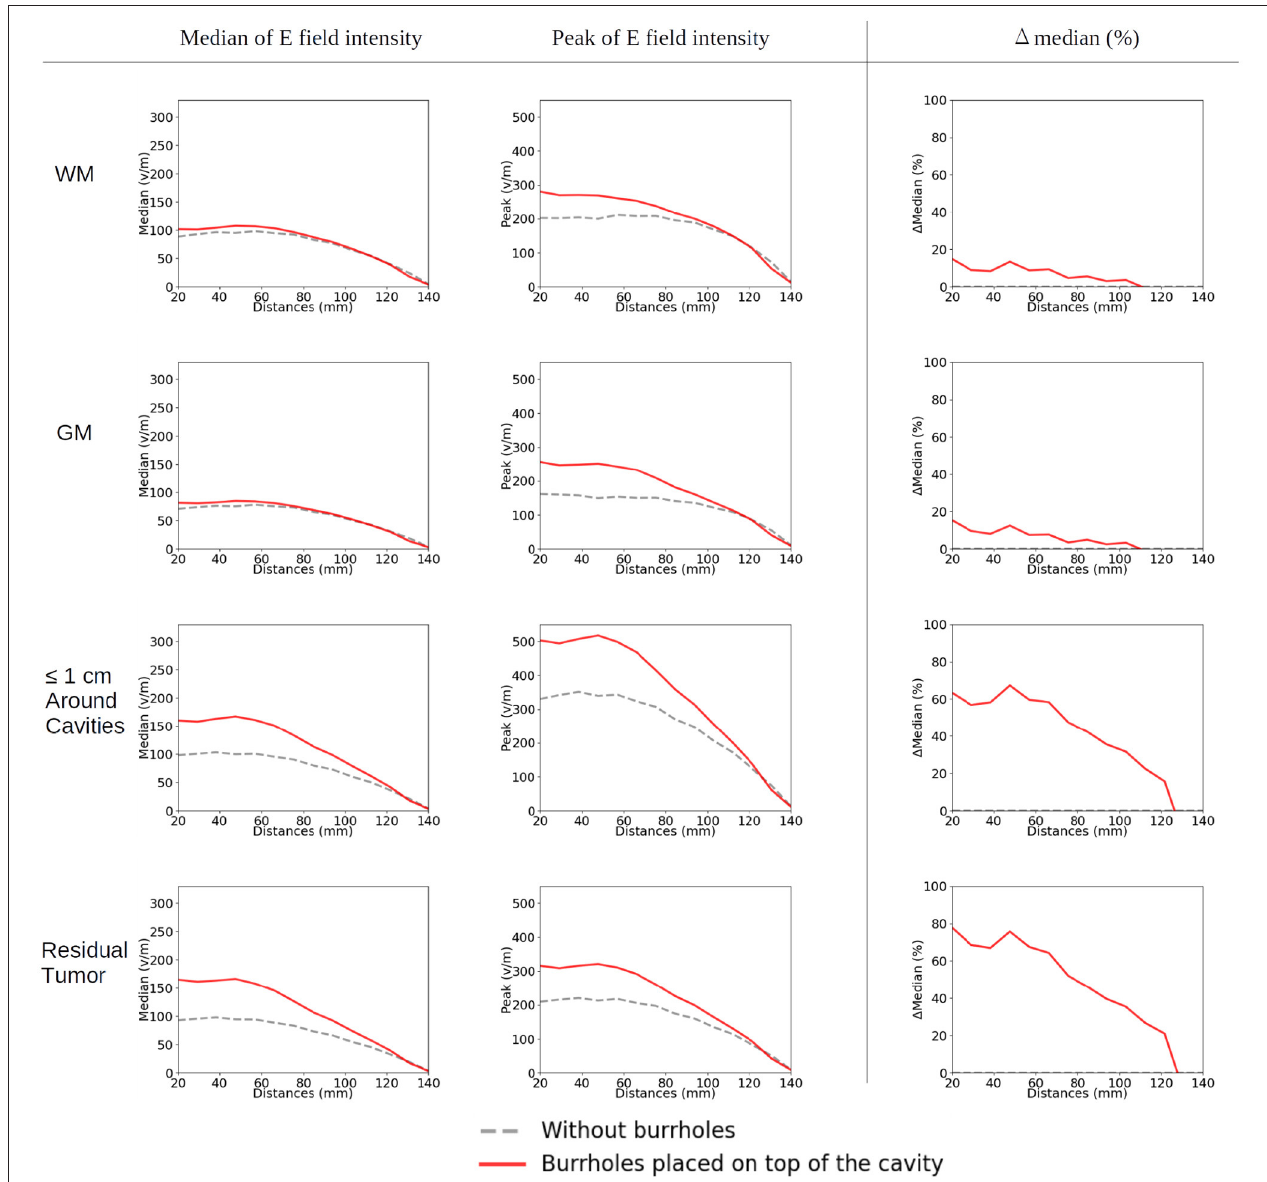
FIGURE 12 | Statistical analysis of TTFields intensities with burr holes directly over the resection cavity and residual tumor (solid red lines) and without burr holes (dashed gray lines). The x -axis shows the moving of the arrays on the skin surface toward the central craniocaudal axis in millimeters ( Figures 4C , 11 , 13 ). The y -axis shows the field strength. The first two columns represent the median and peak values of TTFields intensities for the four tissue types (WM, GM, peri tumor, and residual tumor). The last column shows the field intensity enhancement when SR-surgery is performed. The observed median values of E field on both WM and GM show to be unaffected by burr holes. Namely, the red line with burr holes, and the gray line without burr holes, are close to each other or even overlap. Stronger shunting effects are observed when arrays are placed closer to each other (corresponding to 80–140mm). The electric field drops to near-zero when the two arrays overlap